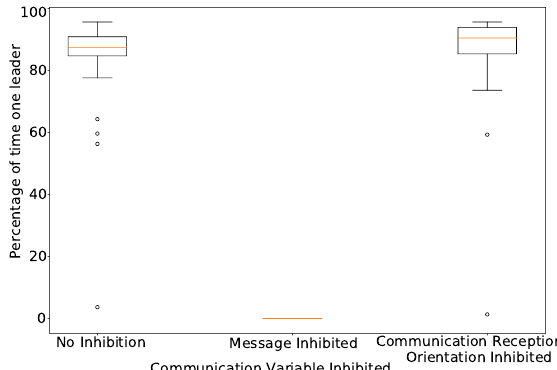
Figure 8. Percentage of simulation time with a single leader elected when communication stimulus are inhibited and in normal conditions. Stimulus inhibition is performed by replacing with zeros the corresponding input stimulus at neural level. Inhibition of the variables is performed separately and one by